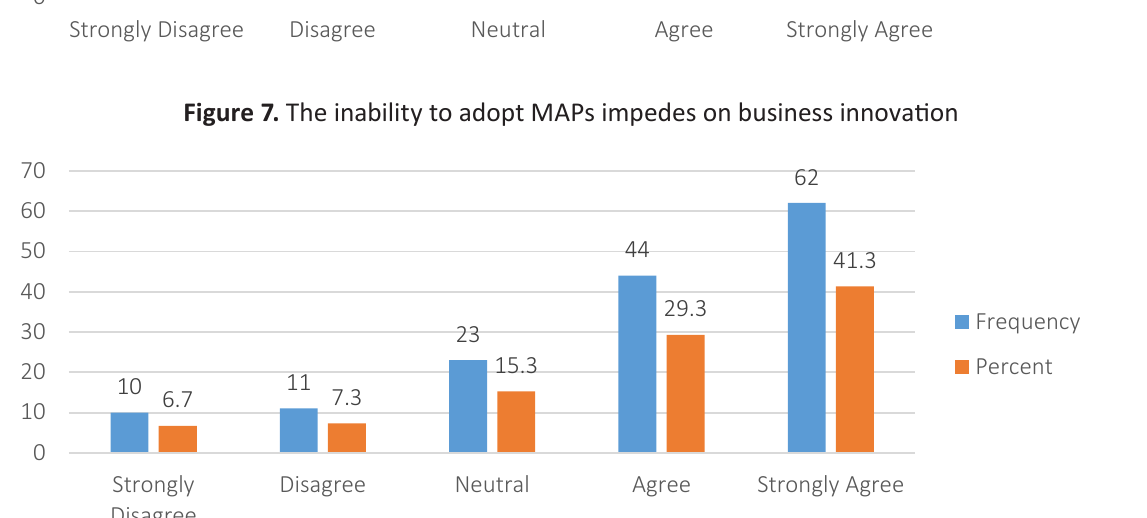
Figure 8. Business innovation can be obtained using relevant